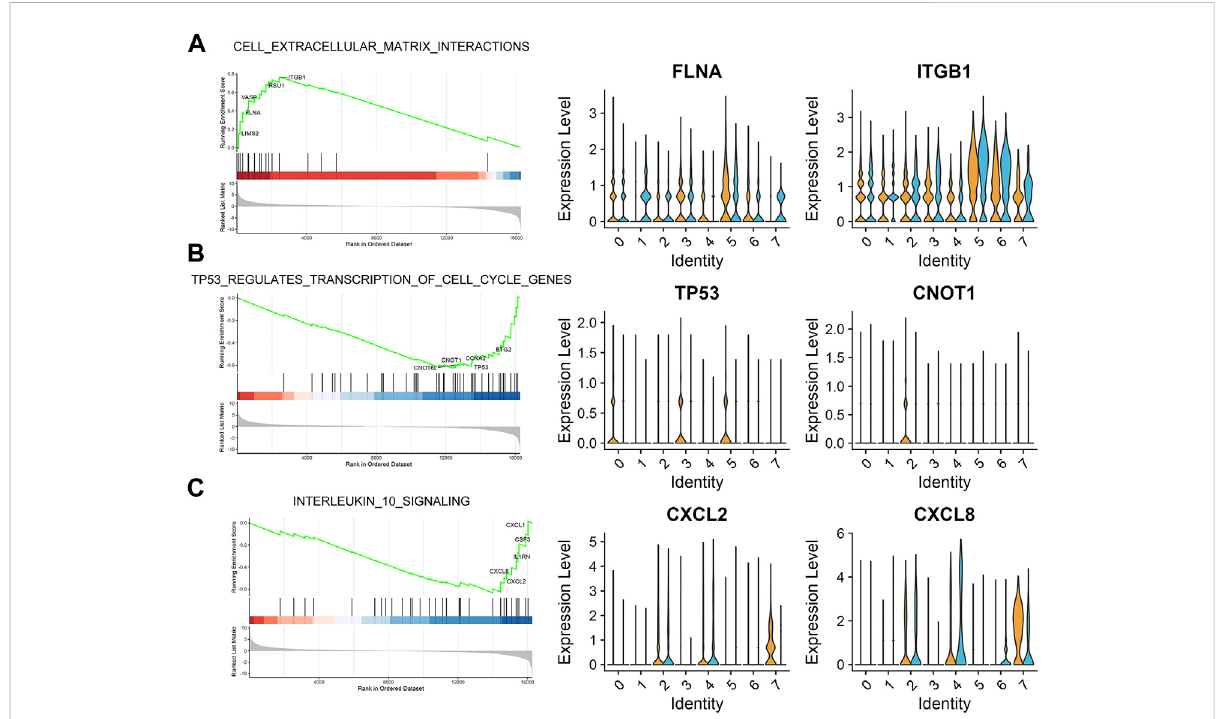
FIGURE 4 Bulk-seqrevealedtheenrichedpathwaysinthinendometrium.GSEAanalysisshowingthepathwaysenrichedinthetop (A) andbottom (B,C) of therankedlist,withthecorrespondingup-ordownregulatedgenes. Left ,combochartshowingtherunningenrichmentscoreandrankedlistmetric for the ordered fold change gene list with 5 pathway genes labeled; right , the expression level of the representative genes in each